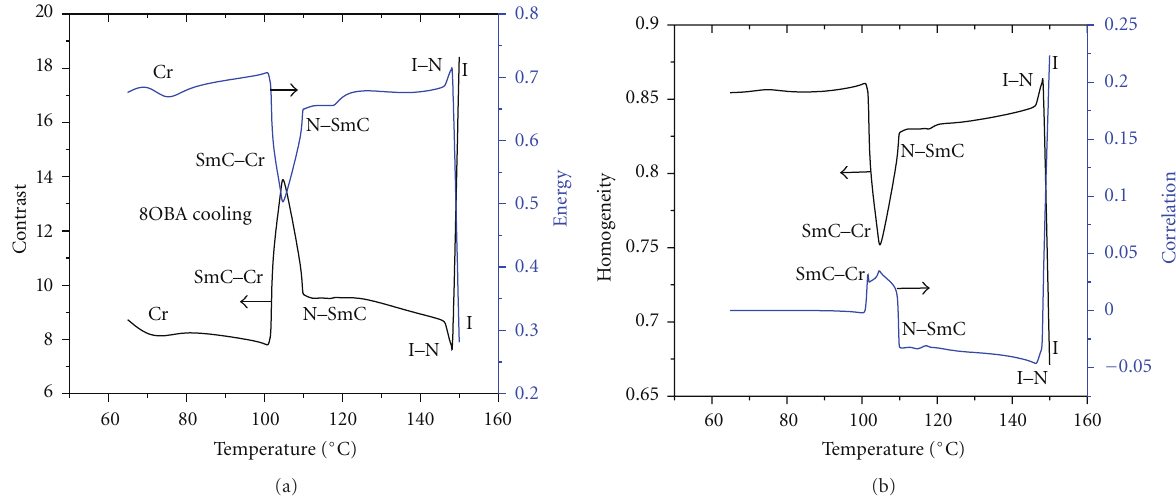
Figure 7: Computed parameters from the textures of 8OBA as a function of temperature where the phase transitions are indicated. (a) Contrast and energy; (b) homogeneity and correlation.